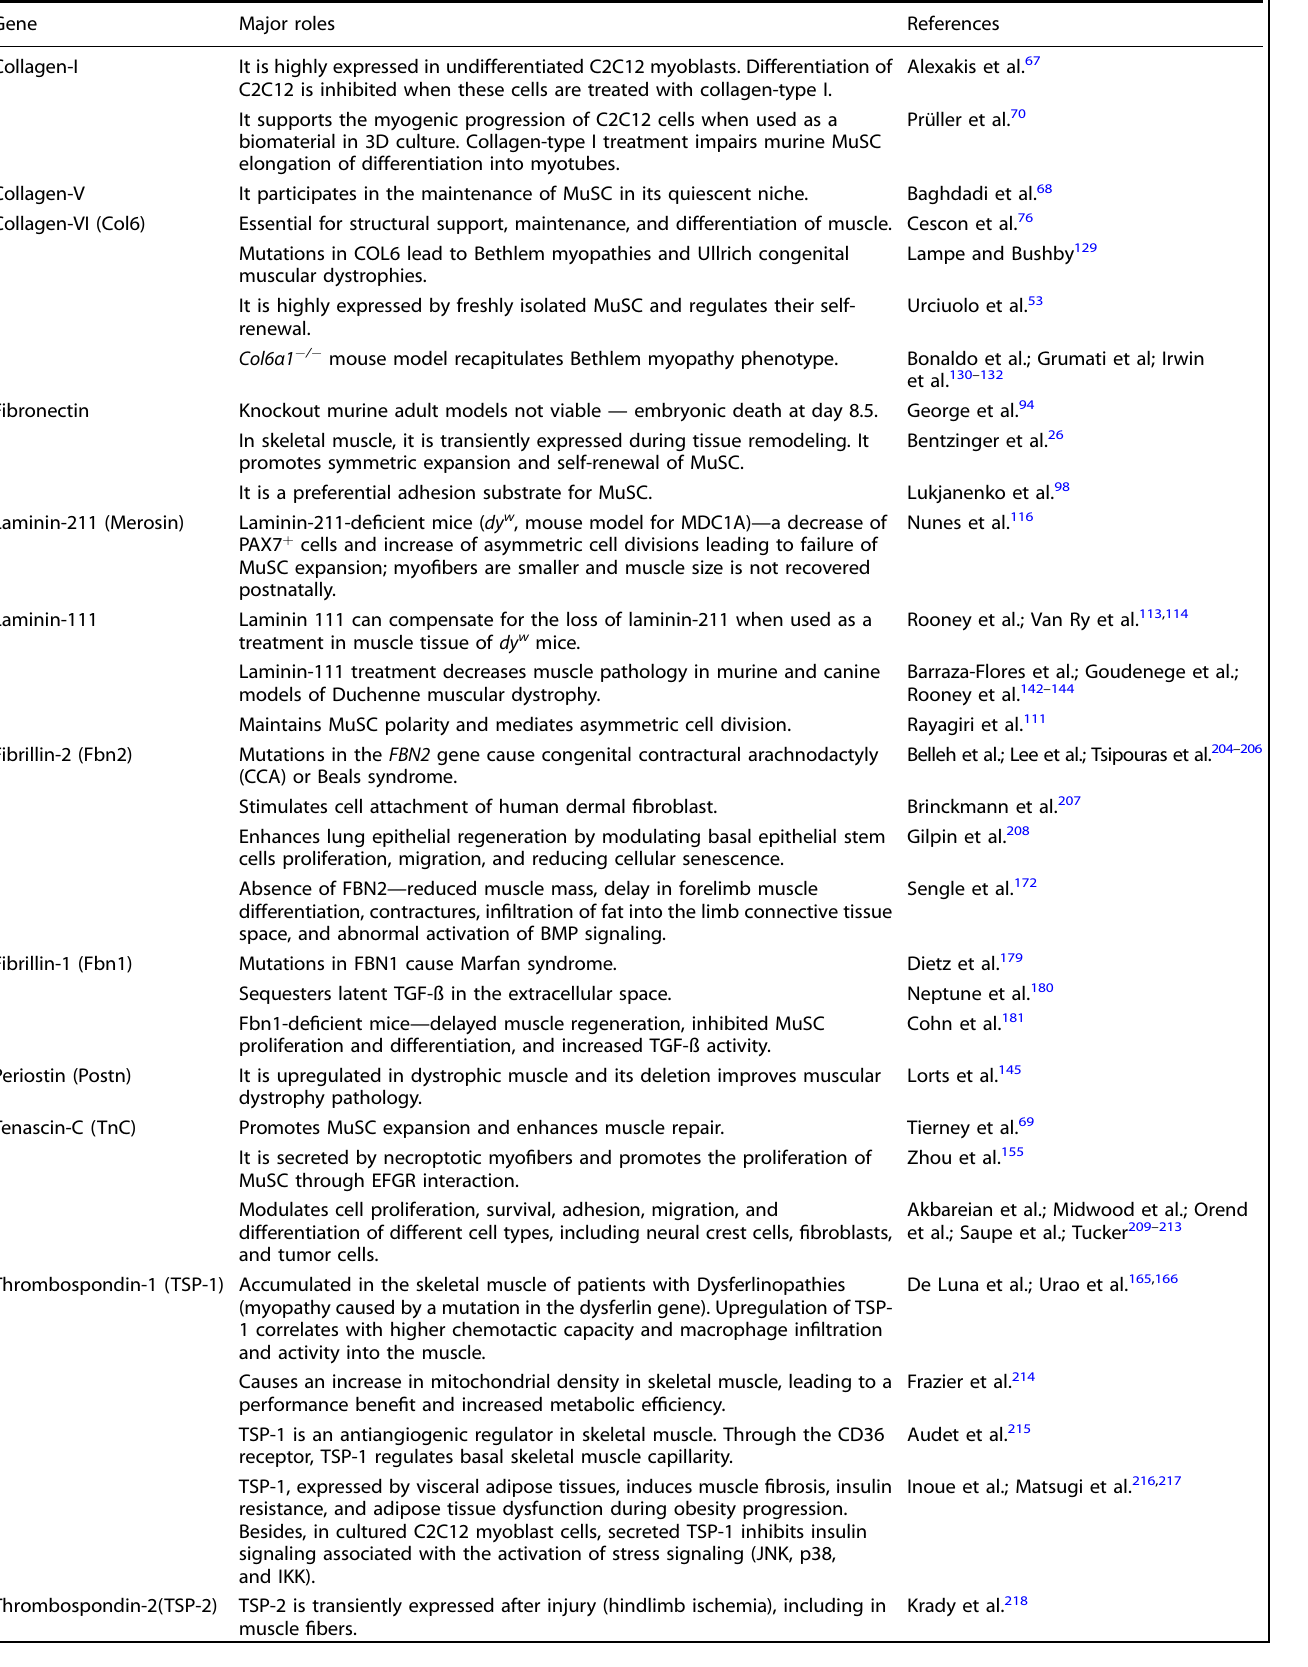
Table 1. The functional regulation of ECM proteins in skeletal muscle and muscle-associated